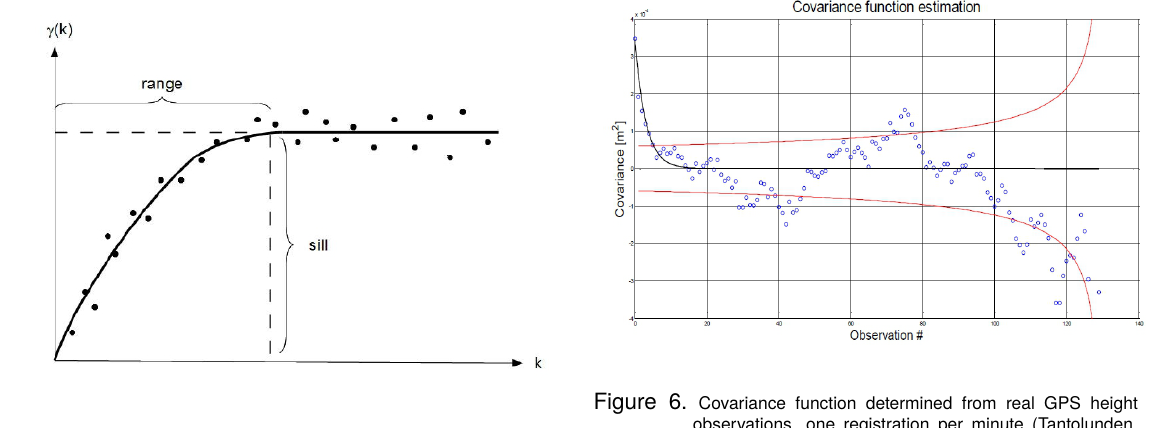
Figure 4. A semivariogram with sill and range.